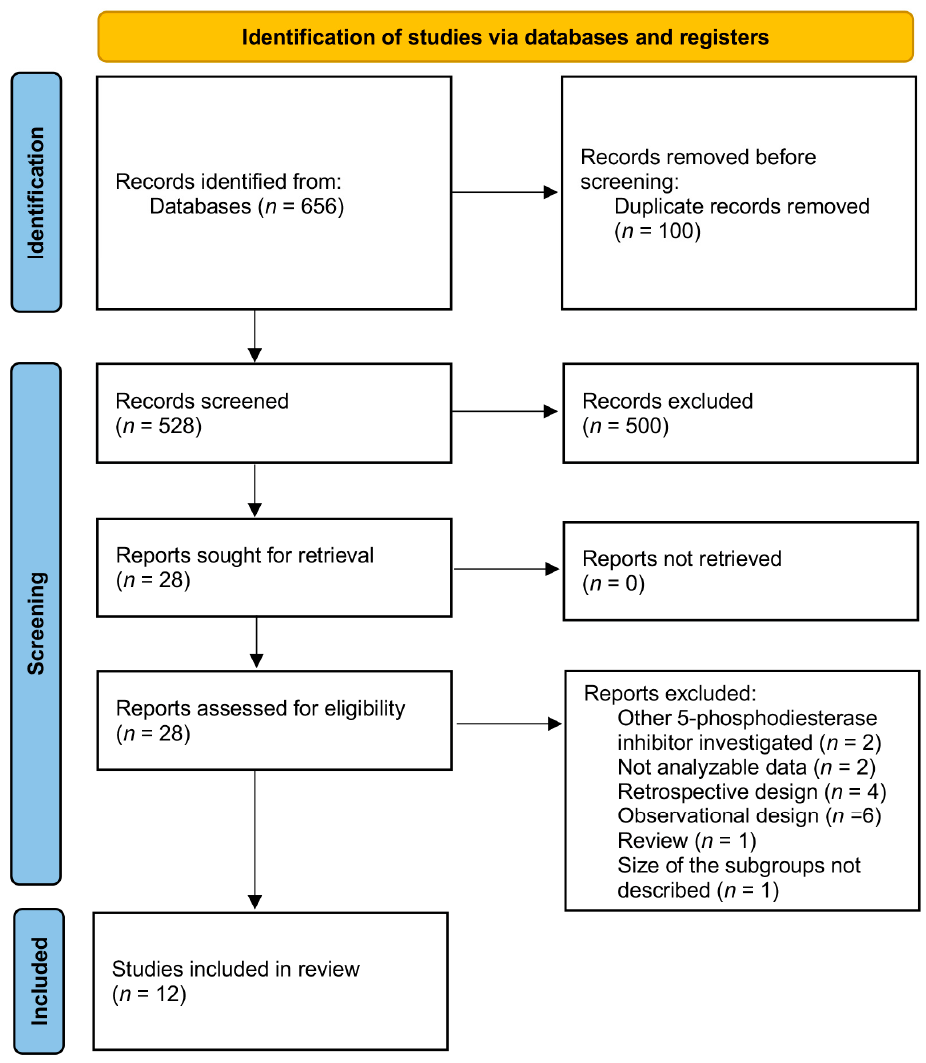
Figure 1. Prisma Flow Diagram.